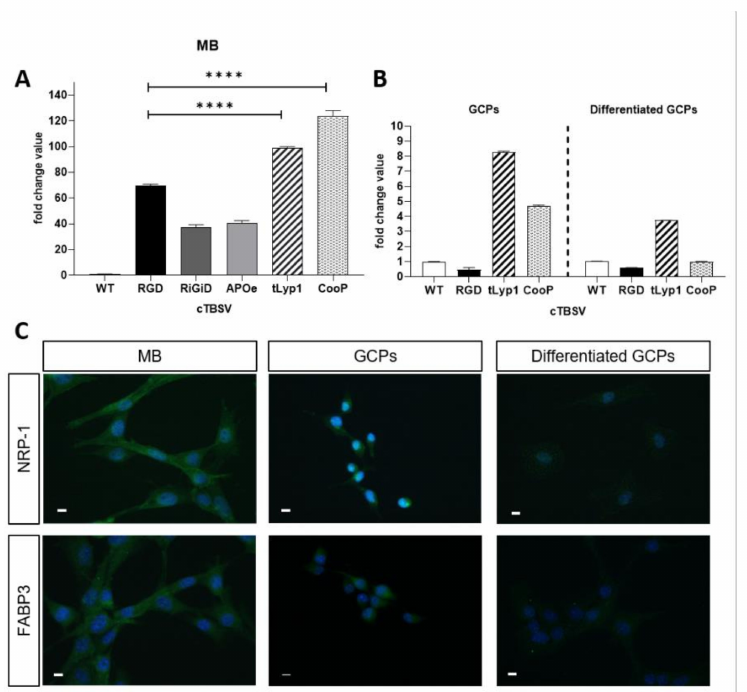
Figure 2. TBSV NPs uptake and receptors immunolocalization . Quantification through qPCR of cTBSV internalized by ( A ) Shh-MB primary cells, ( B ) GCPs (left panel) and differentiated GCPs (right panel) using primers specific for a region in the cp gene common to all cTBSV NPs. Data are presented as mean ± SD of biological triplicates. Values obtained with TBSV-WT were taken as 1. ( C ) Localization by immunofluorescence of tLyp1 and CooP peptides interacting partners NRP-1 and FABP3, respectively. NRP-1 (top line) and FABP3 (bottom line), in Shh-MB, GCPs